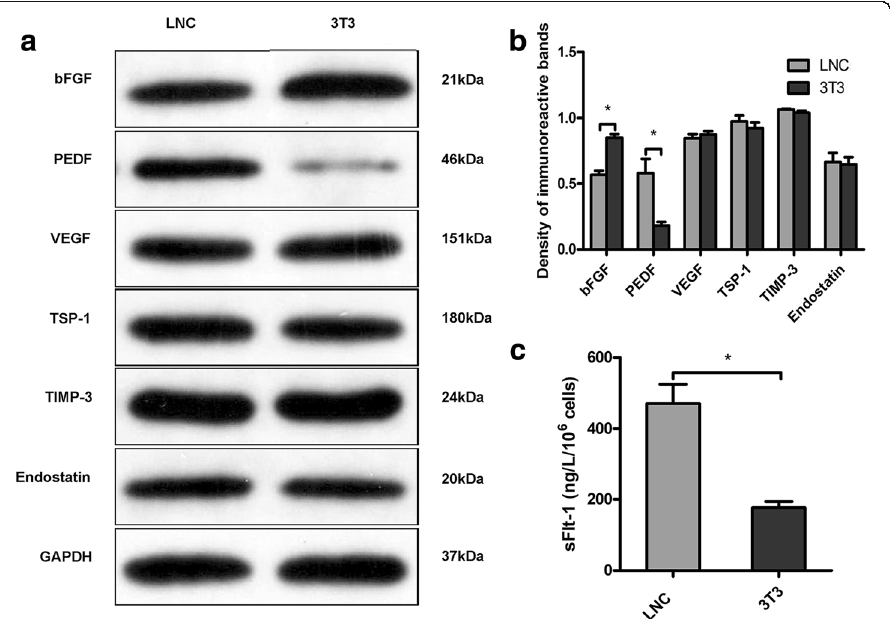
Fig. 6 Expression of angiogenesis-related proteins of cultivated oral mucosal epithelial cells (COMECs) co-cultured with LNCs and 3T3 cells. a Relative protein expression levels of bFGF, PEDF, VEGF, TSP-1, TIMP-3, and endostatin were detected by western blotting normalized with GAPDH. b Densitometric analysis of specific immunoreactive bands was performed. c The sFlt-1 concentrations in the conditioned medium were detected by enzyme-linked immunosorbent assays. The results were expressed as mean±standard deviation. LNCs: limbal niche cells, bFGF: basic fibroblast growth factor, PEDF: pigment epithelium-derived factor, VEGF: vascular endothelial growth factor, TSP-1: thrombospondin-1, TIMP-3: tissue inhibitor of metalloproteinase-3, GAPDH: glyceraldehyde 3-phosphate dehydrogenase, sFlt-1: soluble fms-like tyrosine kinase-1, *: p